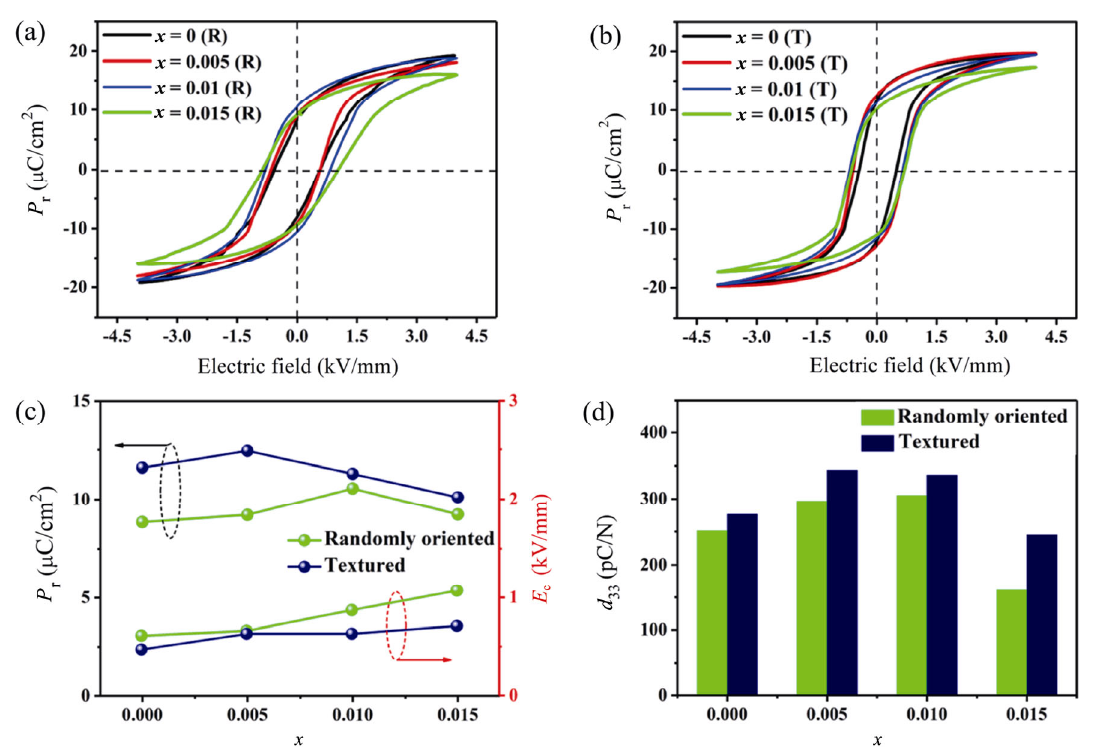
Fig. 7 P – E hysteresis loops of (a) randomly oriented and (b) textured x Er–BCTZ thick films; (c) dependence of P r and E c on x ; (d) comparison of piezoelectric coefficients d 33 of different thick